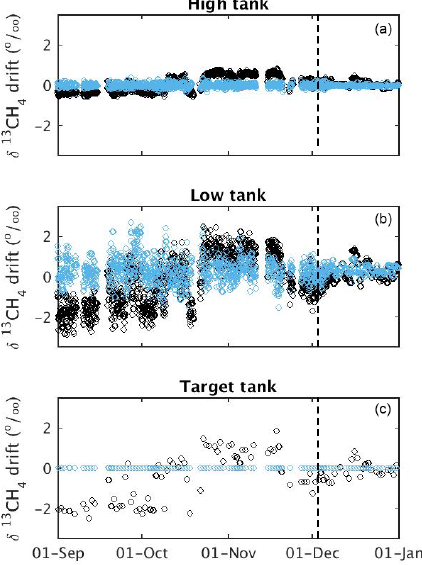
Figure 7. Results following isotopic ratio laboratory calibration only (black) and following calibration (blue) for the south tower for September–December 2016 for the “high” CH 4 mole fraction tank (a) , “low” CH 4 mole fraction tank (b) , and target tank (c) . The target tank was used in the isotopic ratio calibration, whereas the low tank was independent. An improved calibration tank sampling strategy was implemented on 3 December 2016 (indicated by ver- tical dashed lines). The Allan deviation for the time period used for each calibration cycle was, for the period prior to the improved tank sampling strategy, 0.2‰ for the high tank and 0.5‰ for the low and target tanks. Following the implementation of the improved tank sampling strategy, the Allan deviation for each calibration cy- cle was 0.1‰ for the high tank and 0.3‰ for the low and target tanks.